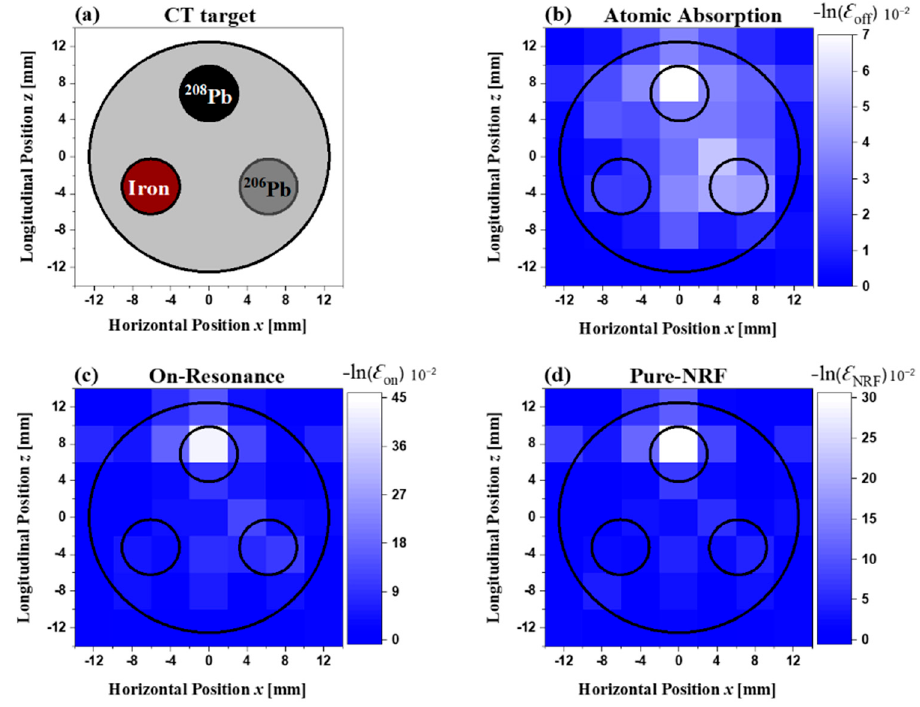
Figure 8. ( a ) CT target cross-sectional slice image at z = 3 mm, as well as reconstructed CT images of the ( b ) atomic attenuation, ( c ) on-resonance attenuation, and ( d ) pure NRF case.